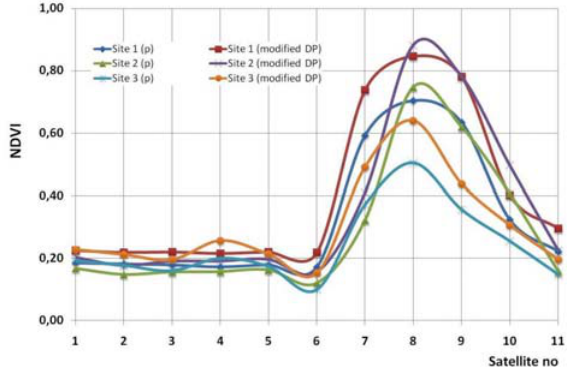
Figure 2. Phenological observations of crops using NDVI before and after the application of the atmospheric correction (from Agapiou et al. 2011b)